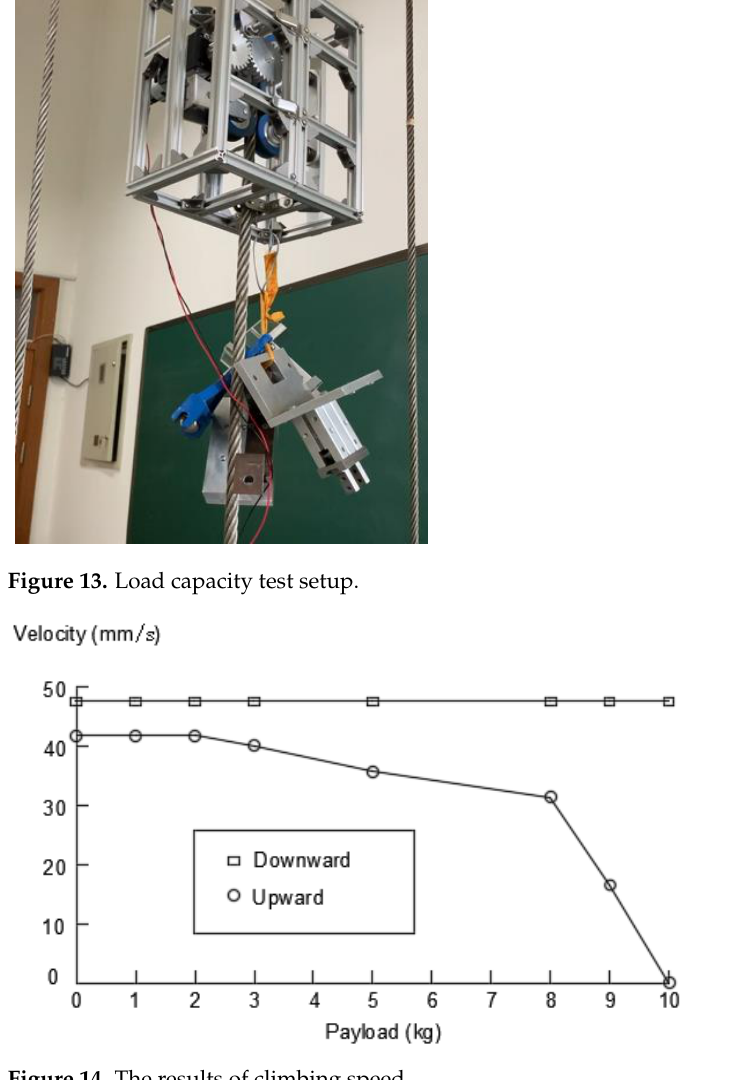
Figure 14. The results of climbing speed.